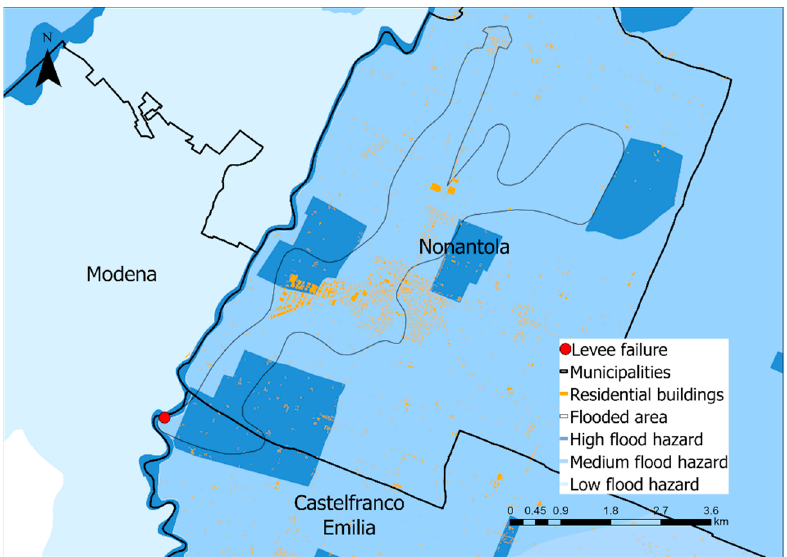
Figure 12. Mapping of the three different flood hazard classes in the study area, and representation of the footprint of the residential buildings inside the flooded surface. The town of Castelfranco Emilia was only in part involved in the flood.